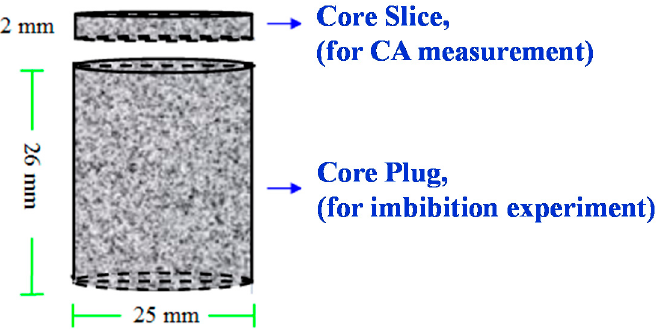
Figure 2. Core sample cutting sketch map. The upper rock slices are used in SEM detection and contact angle measurement, the lower core plugs are used in imbibition test.